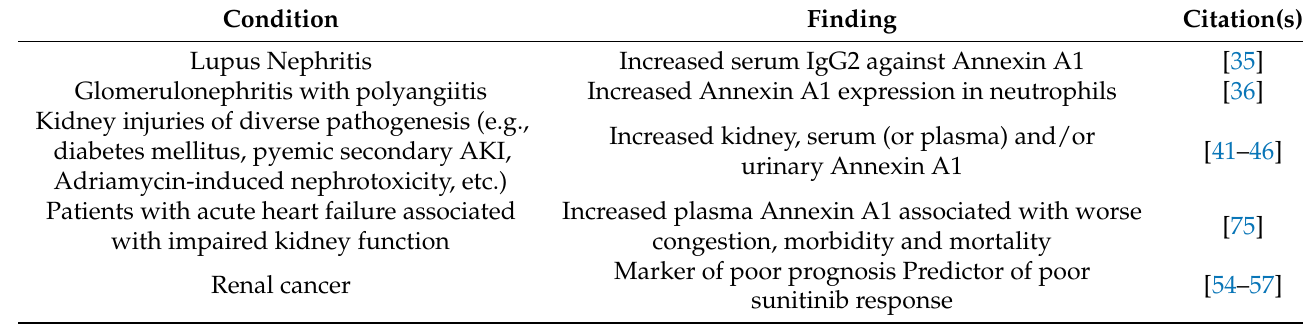
Table 1. Annexin A1 as a diagnostic/prognostic biomarker.